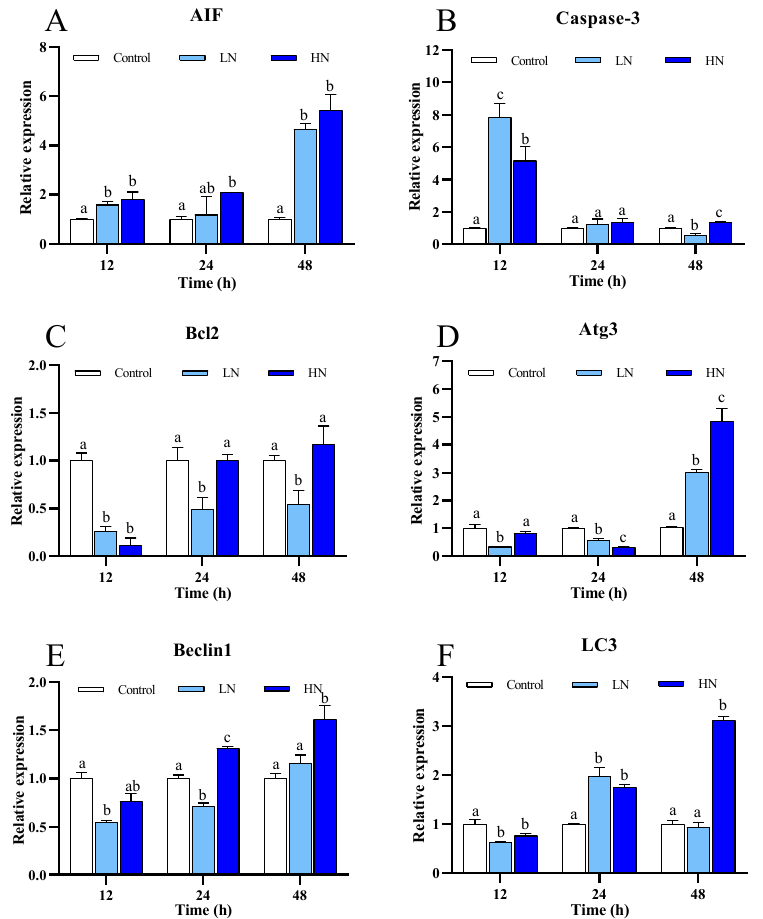
Figure 5. mRNA expression of six genes about apoptosis and autophagy of juvenile P. trituberculatus under nitrite stress. ( A ) AIF , ( B ) Caspase-3 , ( C ) Bcl-2 , ( D ) Atg3 , ( E ) Beclin1 , and ( F ) LC3 . At each time point, the letters indicate significant differences between experimental groups ( p < 0.05).